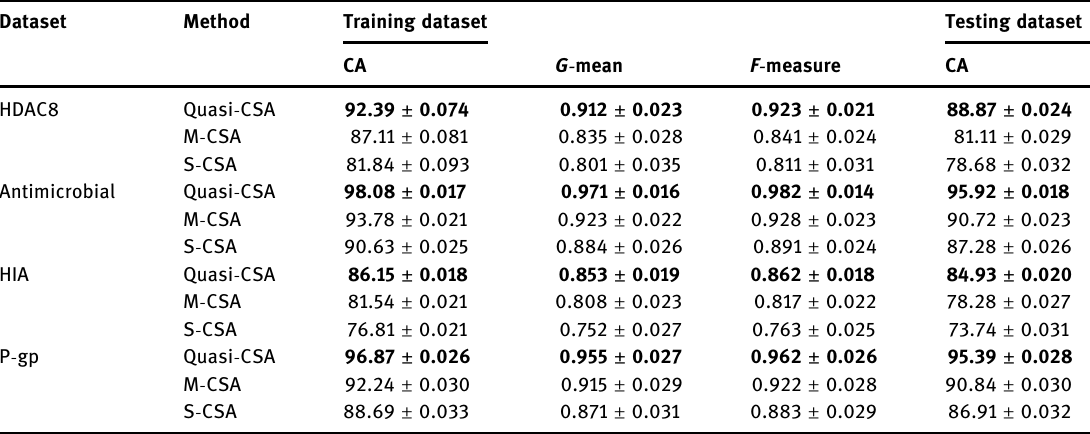
Table 3: Comparison of results of all the methods Dataset